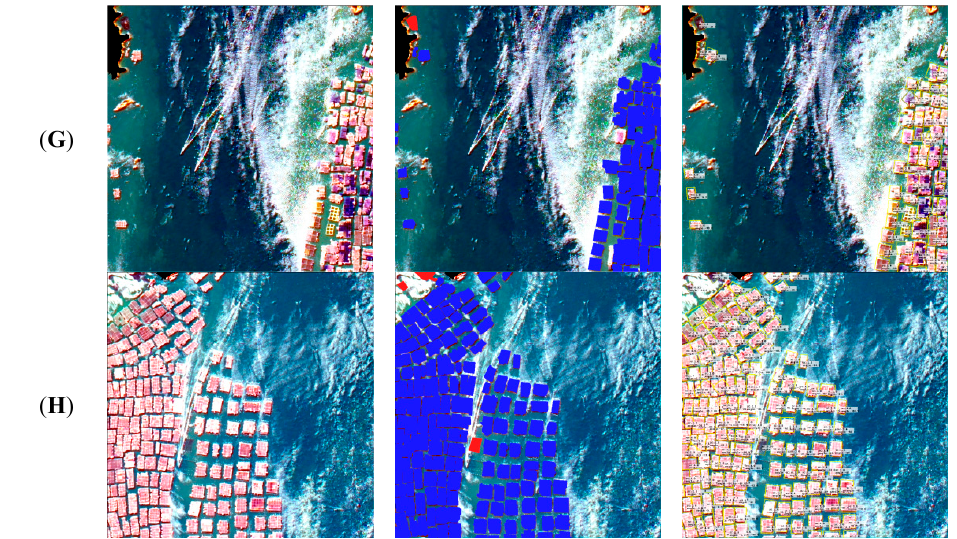
Figure 12. Comparisons of extraction precision of the area of the randomly selected aquaculture zones ( A – H ) in Figure 9. The blue patches represent cage aquaculture zones, and the red patches represent raft aquaculture zones. Table 7. Extraction precision of the R 3 Det model for the area of the aquaculture zone.